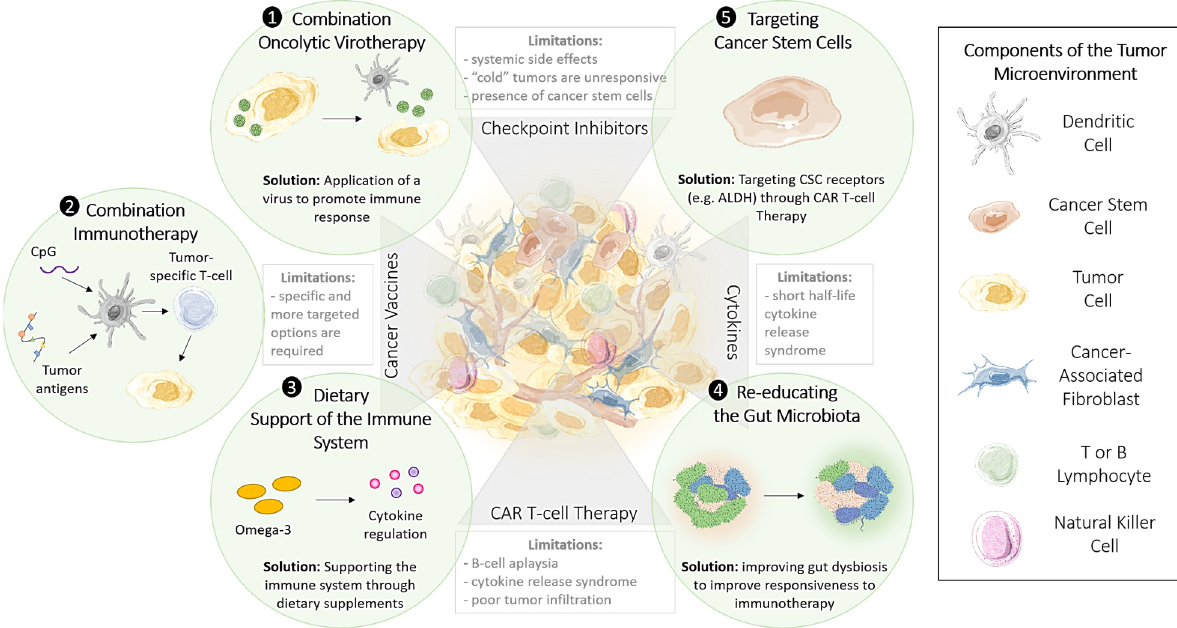
Figure 2. Solutions to overcoming the limitations of immunotherapy. Several viable options could potentially overcome the limitations presented by immunotherapies. ( 1 ) Targeting cancer stem cells; given their unique biology, are not currently targeted by conventional immunotherapies. ( 2 ) A combination therapeutic approach, using oncolytic viruses to promote a more robust immune response upon tumor cell lysis, would release tumor antigens into the microenvironment. These tumor-specific antigens would then be recognized by immune cells and could elicit a robust response and enhance tumor cells’ clearance. ( 3 ) Combination immunotherapy using a CpG vaccine to prime dendritic cells to recognize antigens, followed by T cells’ presentation, could lead to a more localized and targeted systemic anti-tumor immune response. ( 4 ) Dietary supplements to support the immune system, and finally, ( 5 ) re-educating the gut microbiota may improve the immune system’s competency and improve patient response to immunotherapy. Abbreviations: ALDH, aldehyde dehydrogenase; CAR T cells, chimeric antigen receptor T